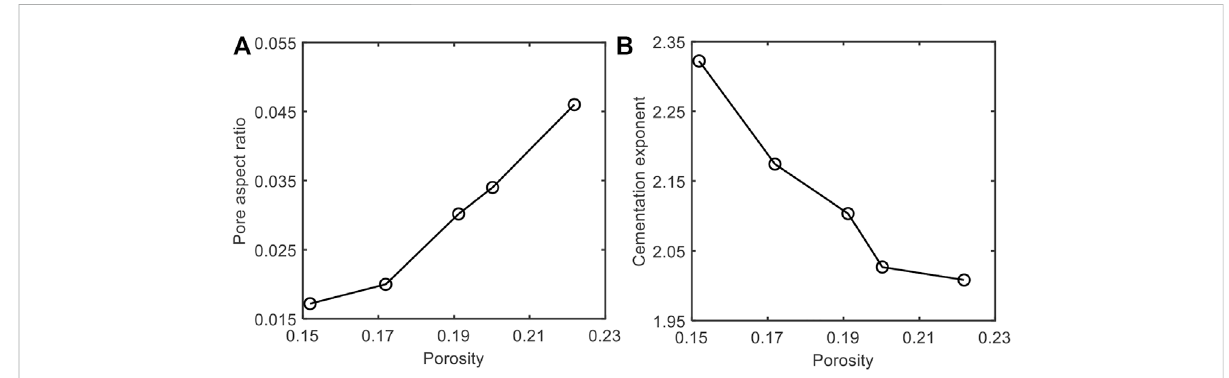
Variation of the (A) pore aspect ratio inverted from P- and S-wave velocities and (B) cementation exponent obtained from resistivity with porosity of the samples.